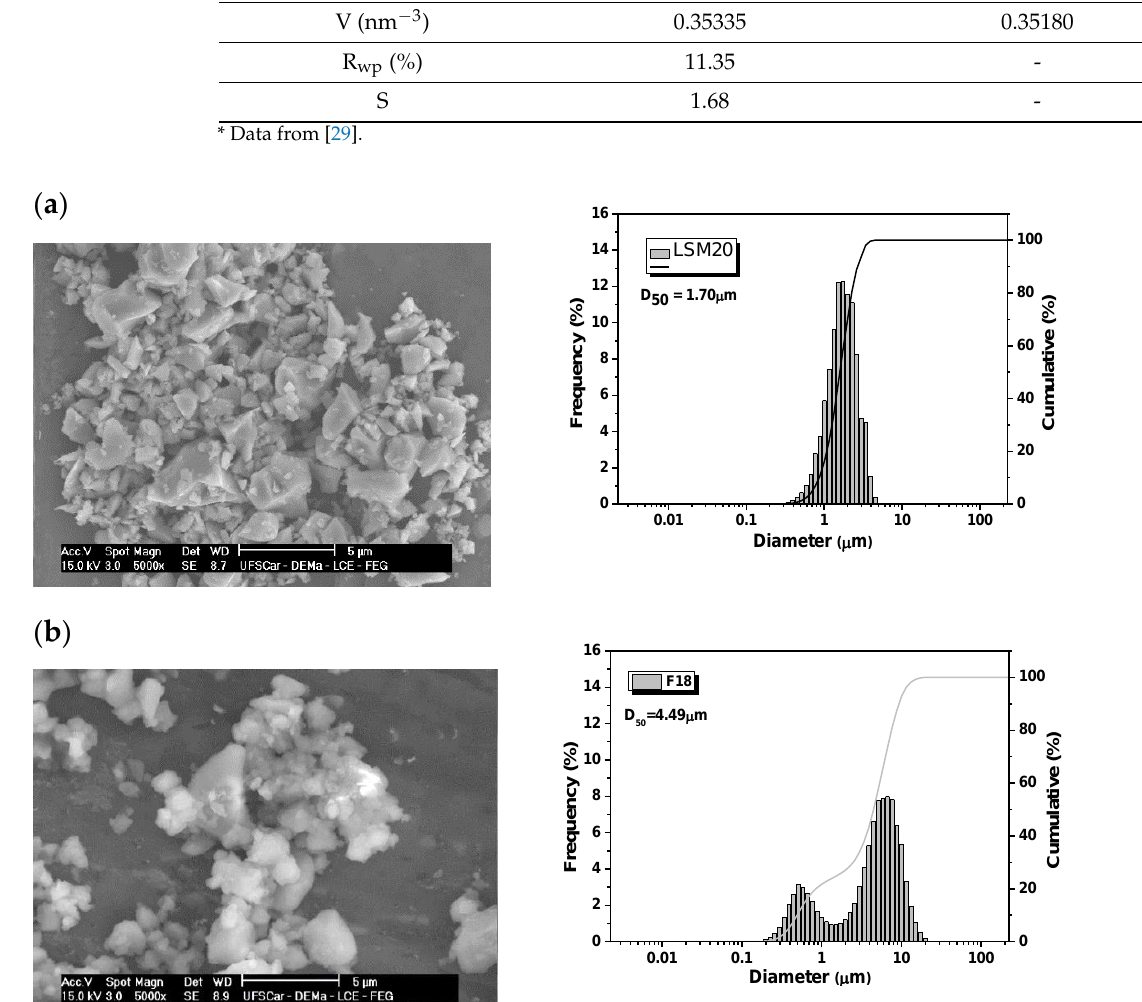
Figure 5. SEM images and the particle size distribution by diffraction laser ( a ) LSM particles ( b ) F18 particles.